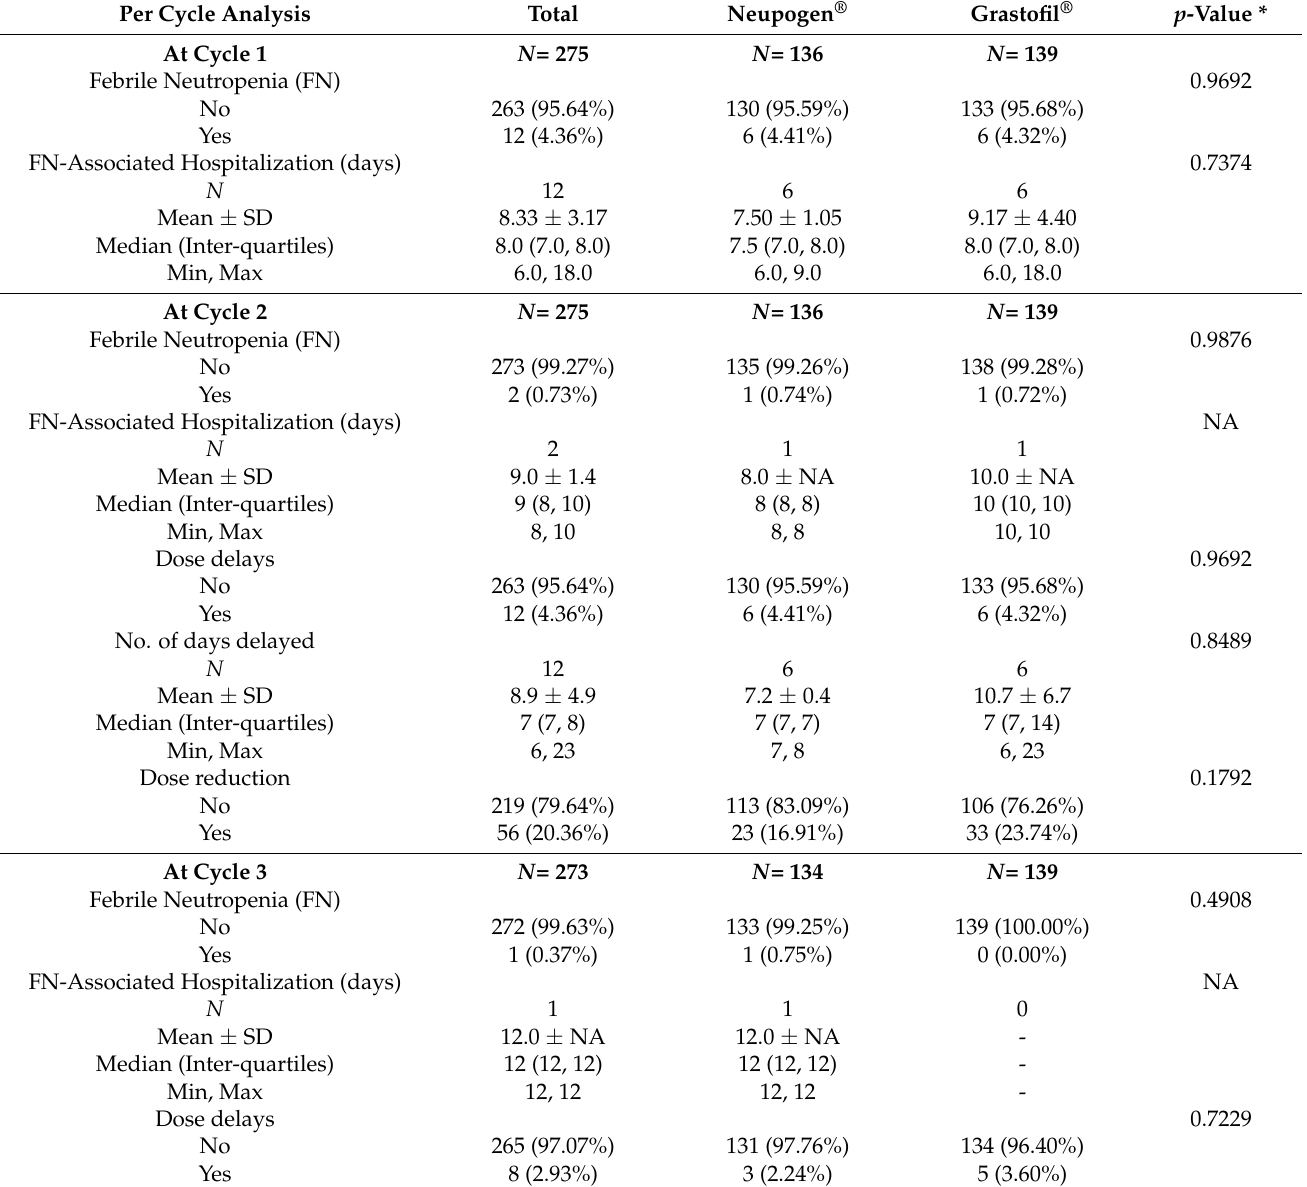
Table A1. Cycle-per-Cycle Outcomes in Breast Cancer